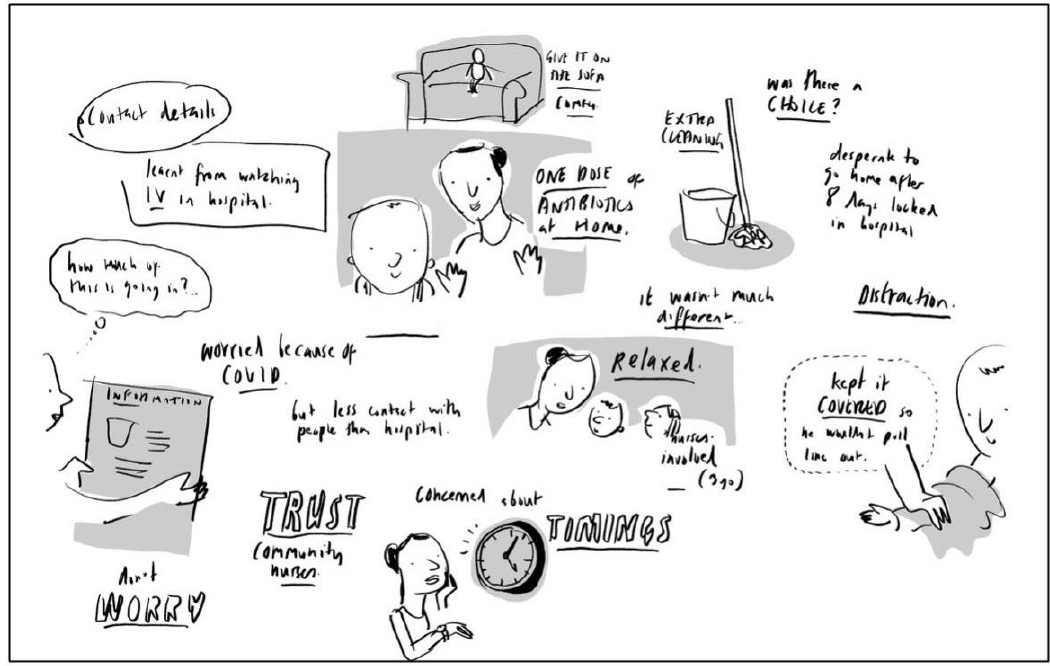
Figure 8. Annotated and illustrated ‘ map ’ of a child ’ s experience ( child’s name redacted ) .